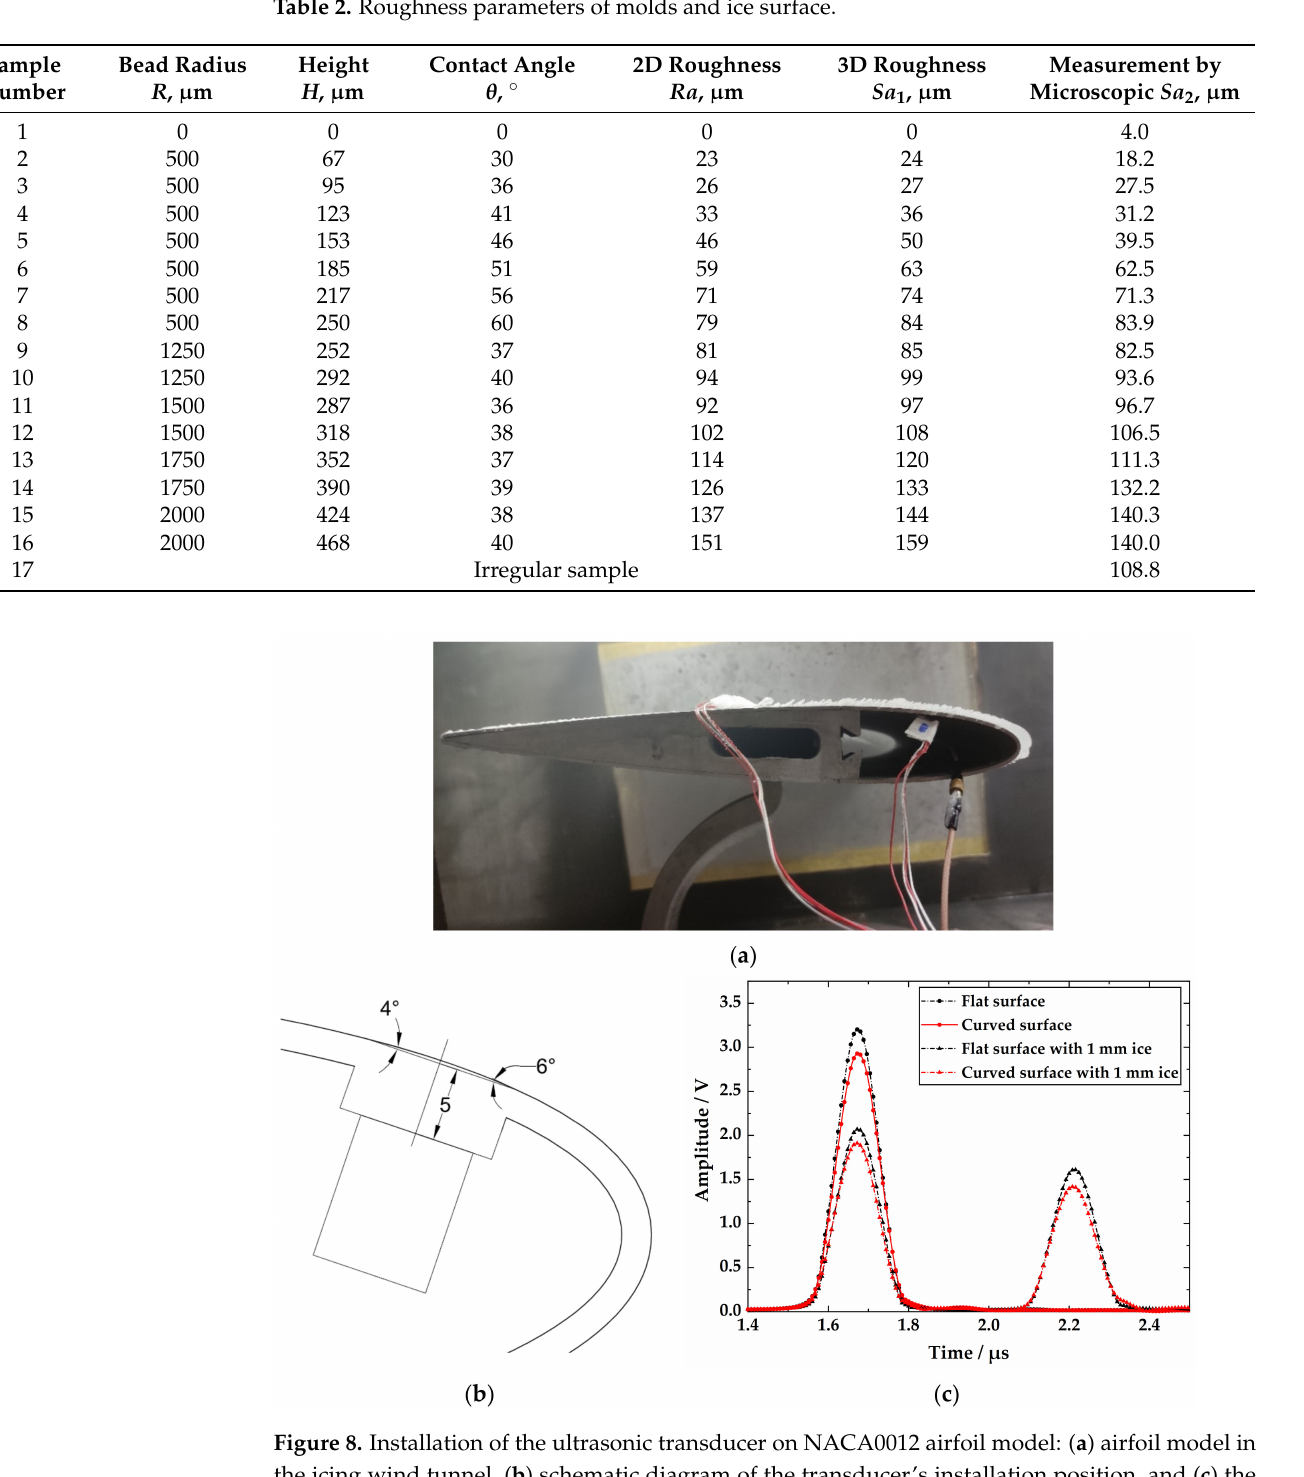
Table 2. Roughness parameters of molds and ice surface.